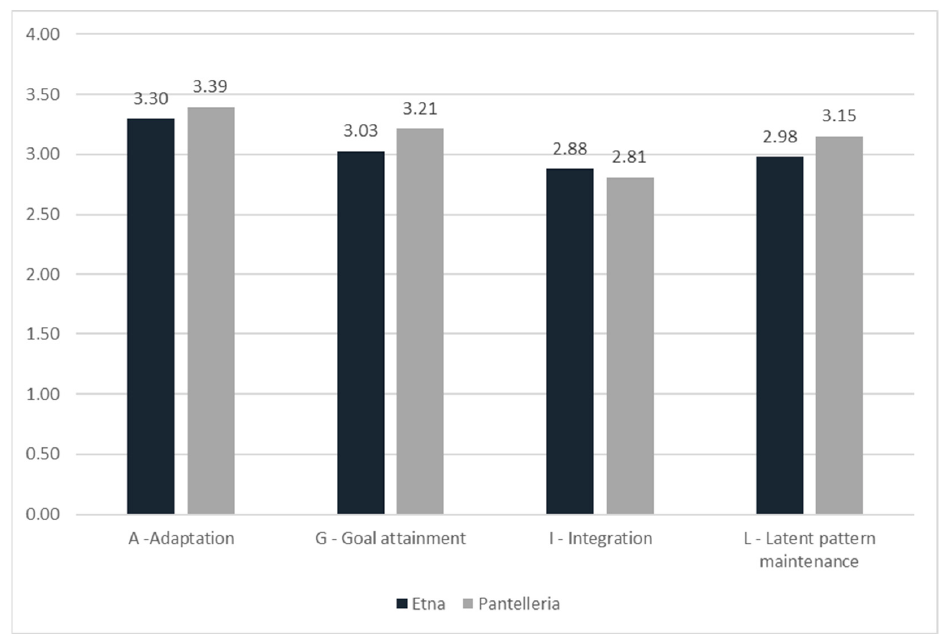
Figure2. ComparativeanalysisbetweenmeanvaluesobtainedforthefourAGILdimensions(Pantelleria Figure 2. Comparative analysis between mean values obtained for the four AGIL dimensions vs. Mount Etna). Agronomy 2020 , 10 , 721 (Pantelleria vs. Mount Etna).